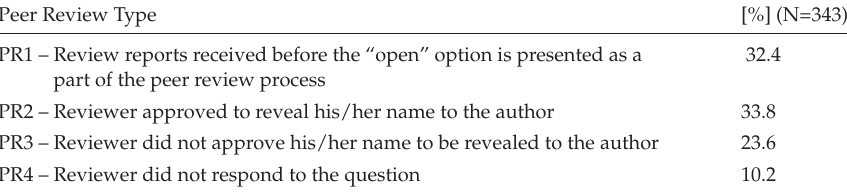
Table 6: Groups of revisions regarding the openness of the review reports [%].